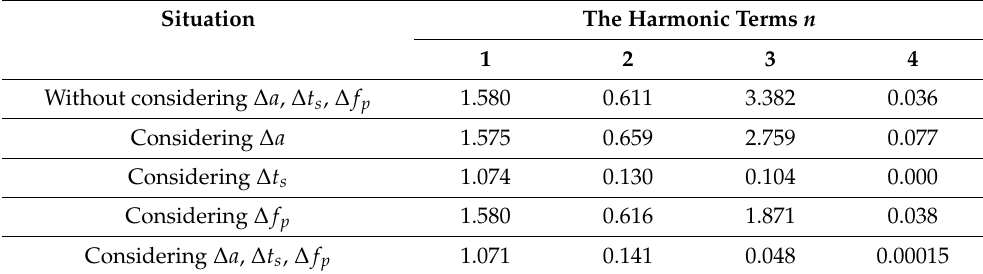
Table 11. Displacement response contributions from each of the harmonic terms.